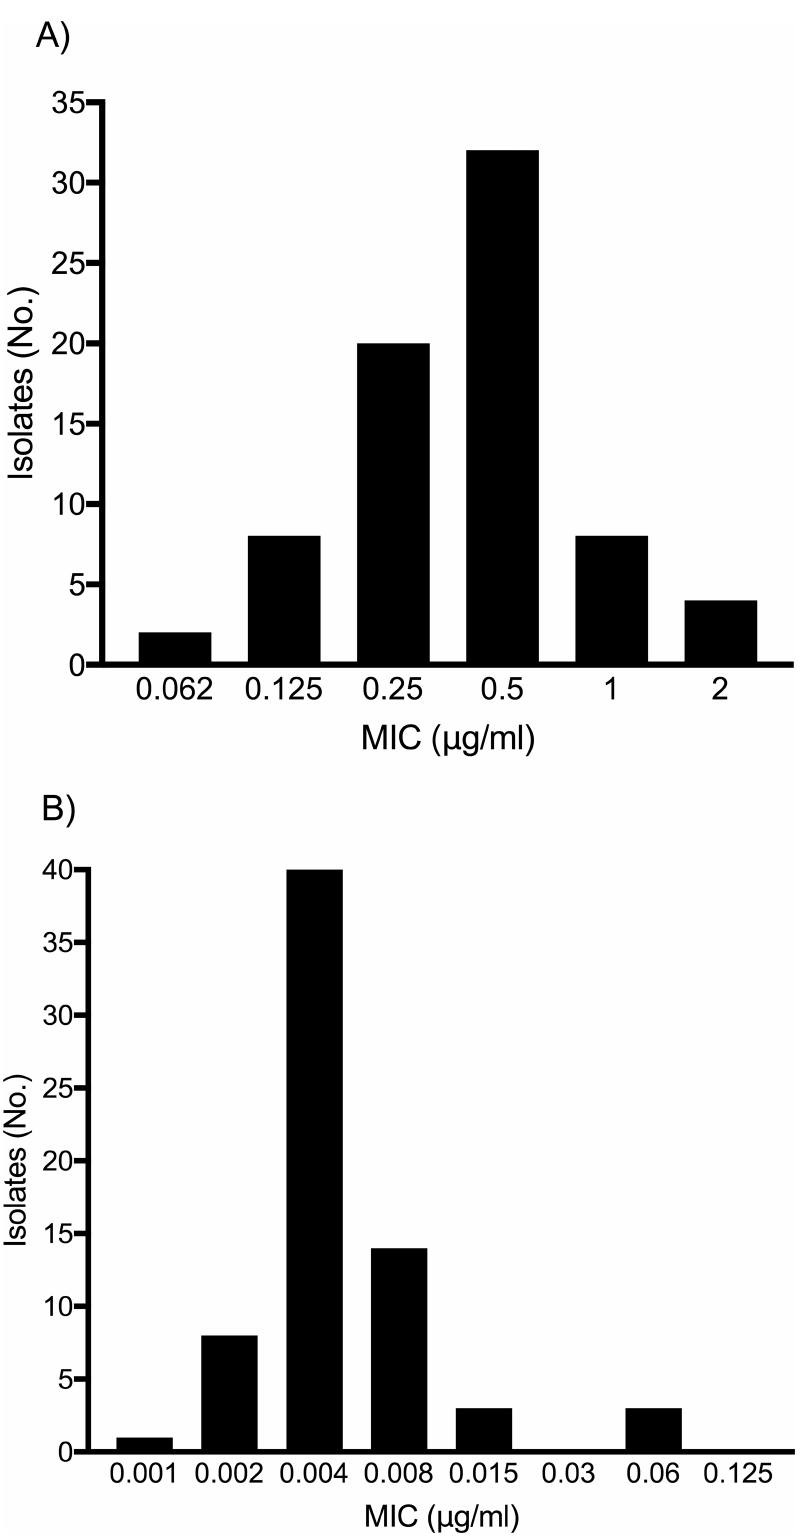
Fig 3. Susceptibility of Cutibacterium spp. to levofloxacin (A) and rifampin (B), expressed as distribution of MIC values. MIC, minimal inhibitory concentration.